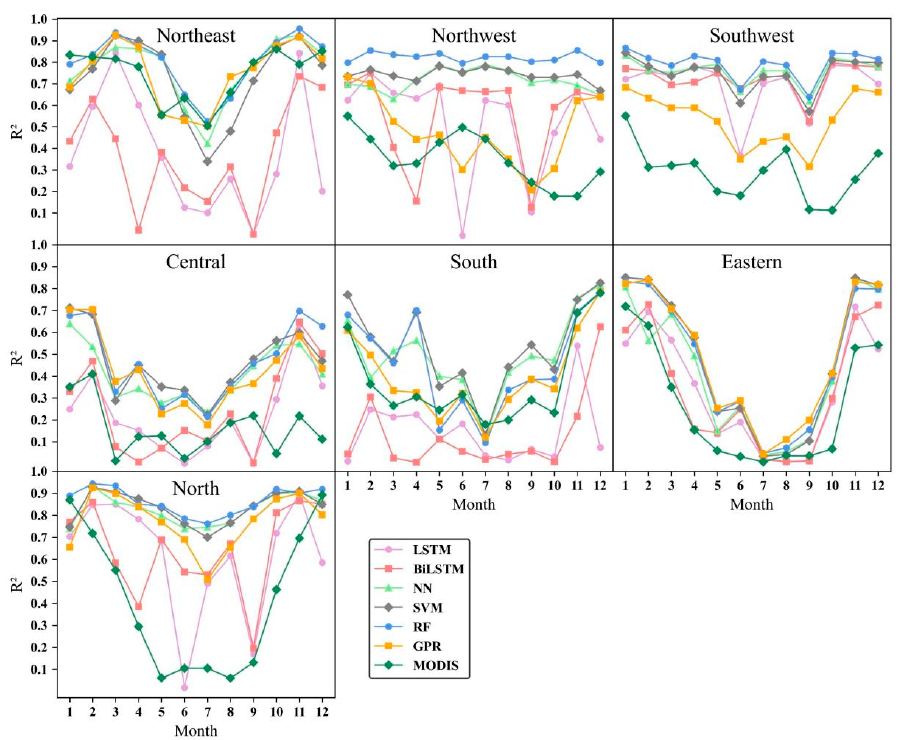
Figure 17. R² values by month for different